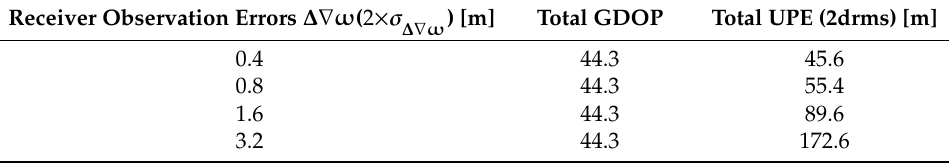
Table 7. Simulation results: MDPO algorithm performance